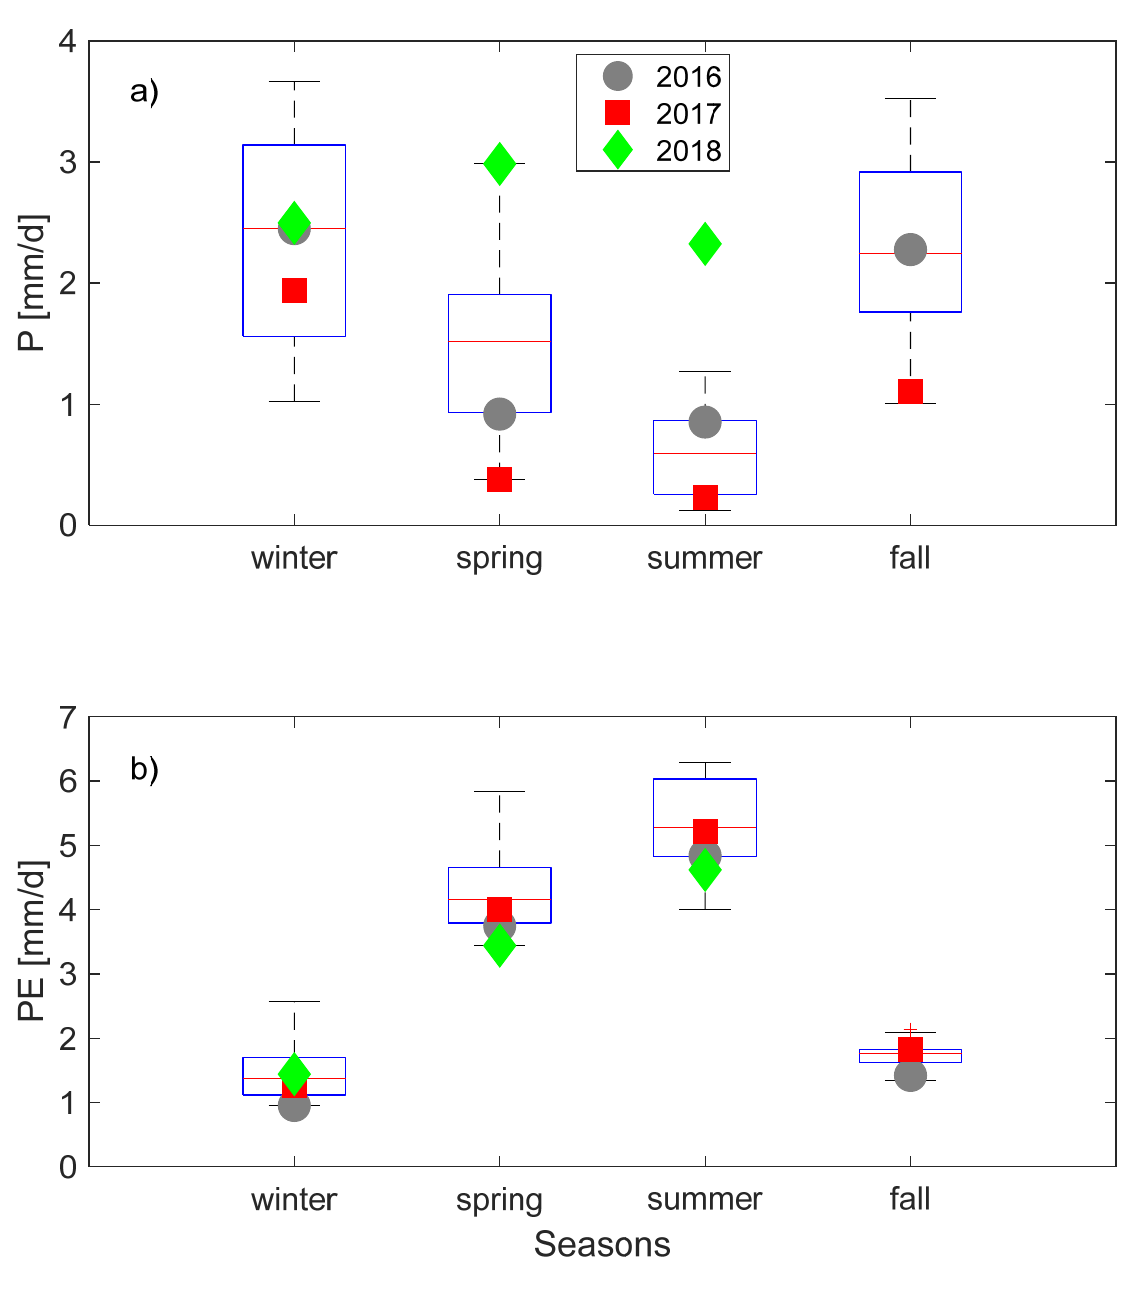
Figure 2. Statistics of the seasonal ( a ) precipitation (P), and ( b ) potential evaporation (PE) at the Sardinian site in relation to the 2003–2018 period (in each box, the red line indicates the median, the box and whiskers represent quartilies, and outliers are depicted individually). The seasonal values of 2016, 2017, and 2018 years are indicated.